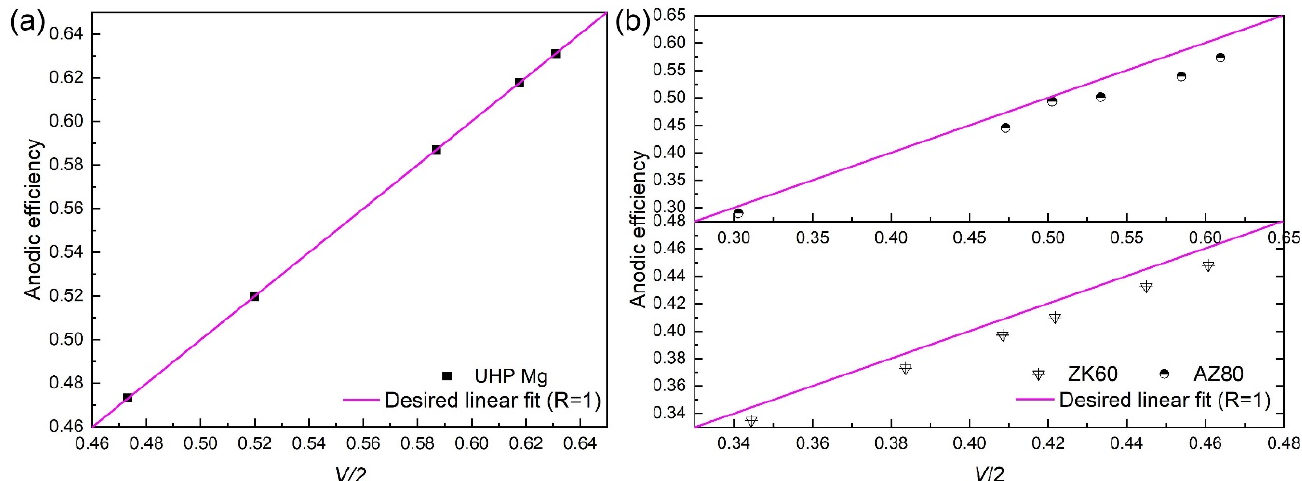
Figure 22. The relationship [101] between anodic efficiency and V e,ibattery /2 during battery testing for ( a ) UHP Mg, ( b ) AZ80 and ZK60. This provides an explanation for the low values of anodic efficiency for Mg anodes in terms of the Mg corrosion mechanism This also provides a methodology for the design and production of more efficient Mg anodes.